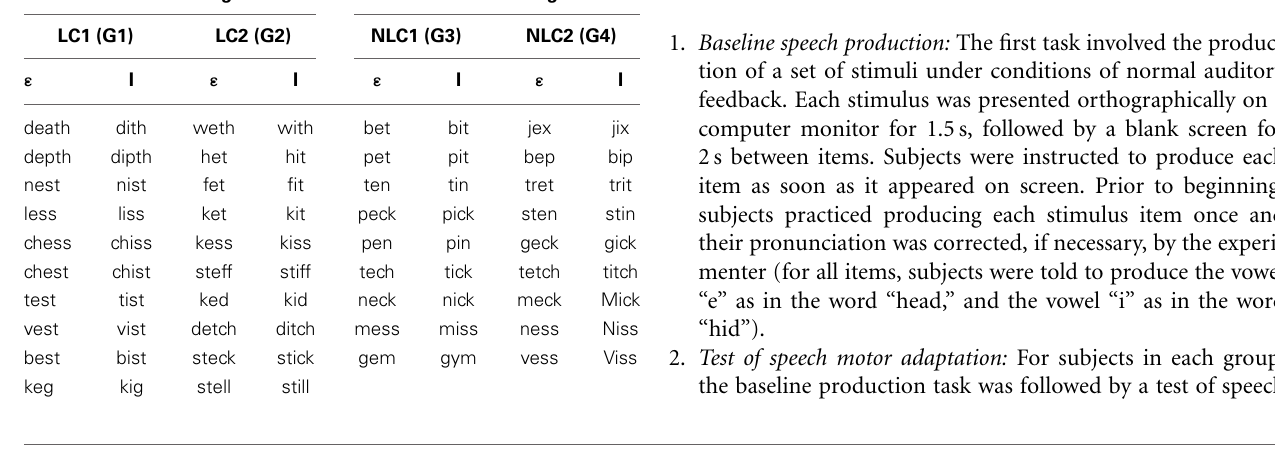
Table 2 | Control measures for experimental stimuli, including neighborhood density (ND) and word-average bi-phonemic probability (PB).